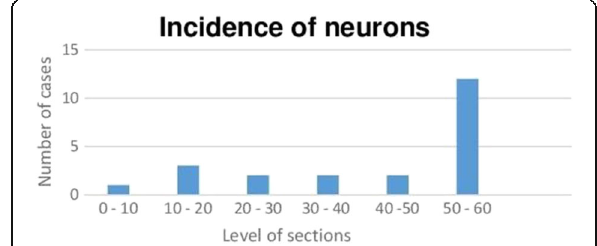
Fig. 2 Location of ganglion cells using HE staining.